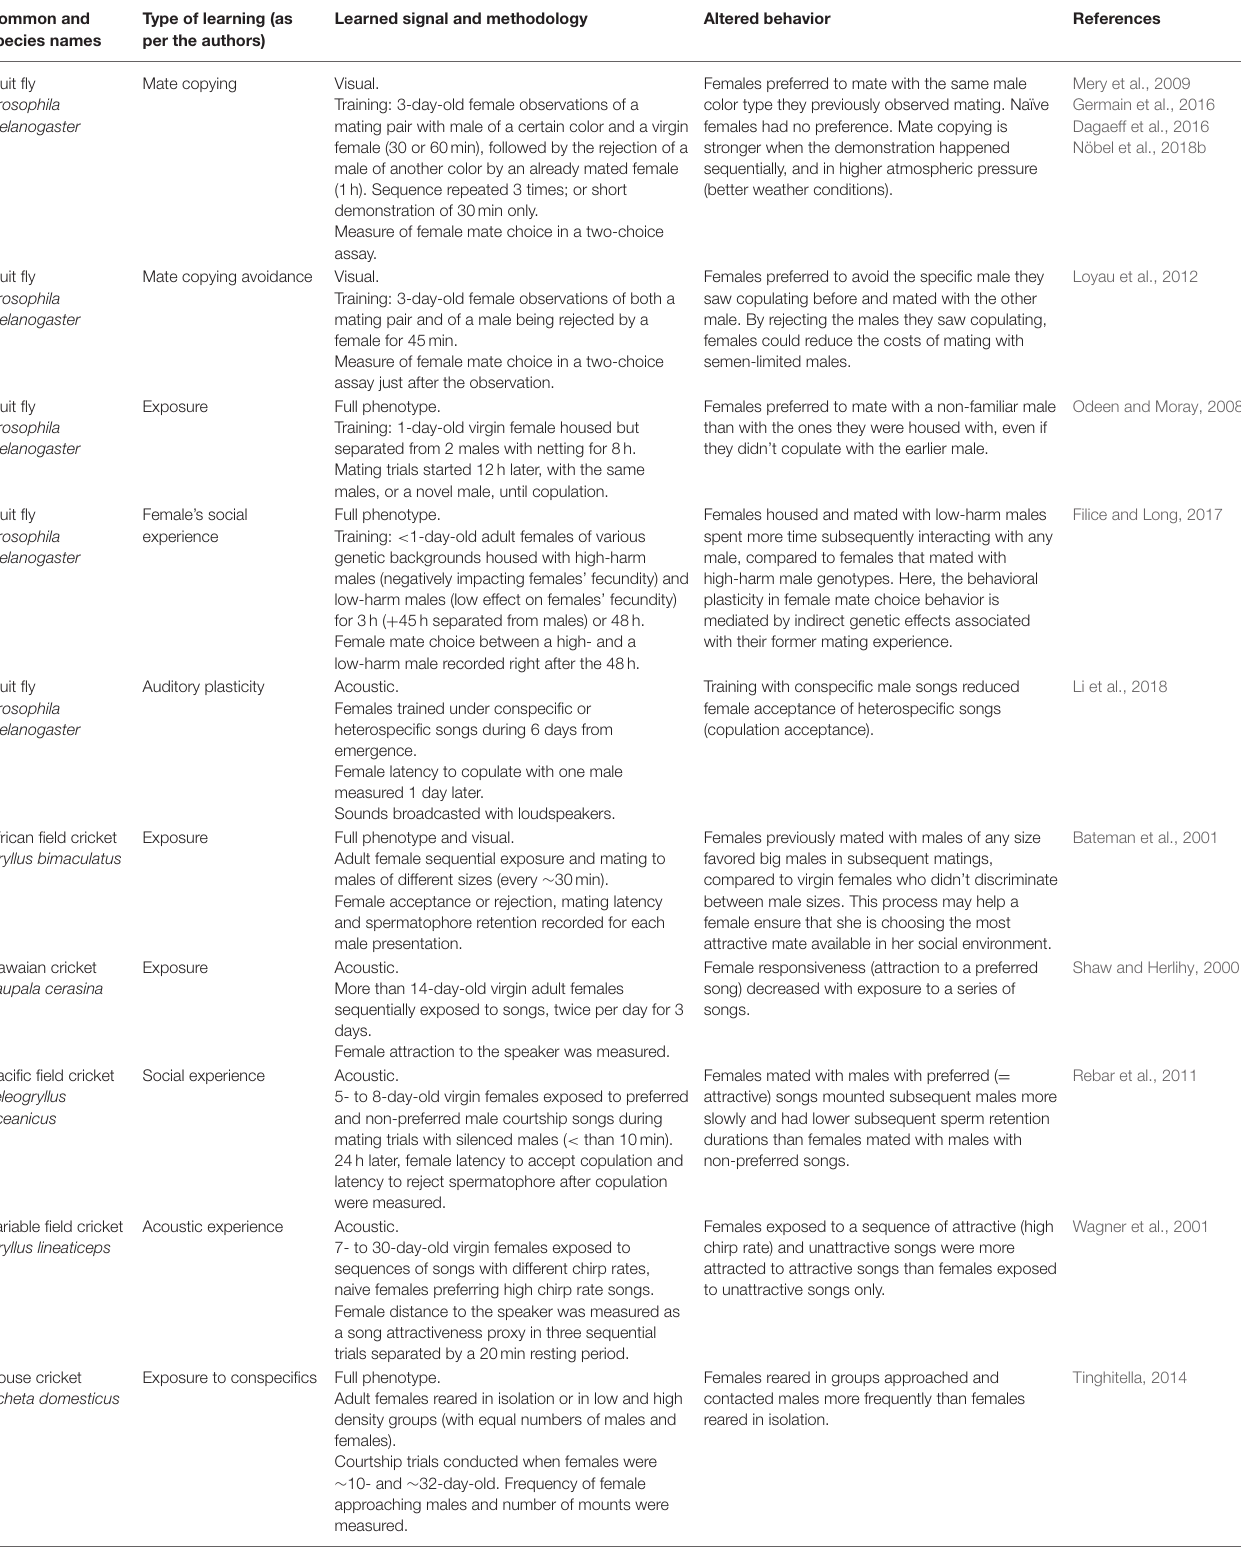
TABLE 2 | A non-exhaustive list of publications about how female insects and spiders learn sexual behaviors. Common and species